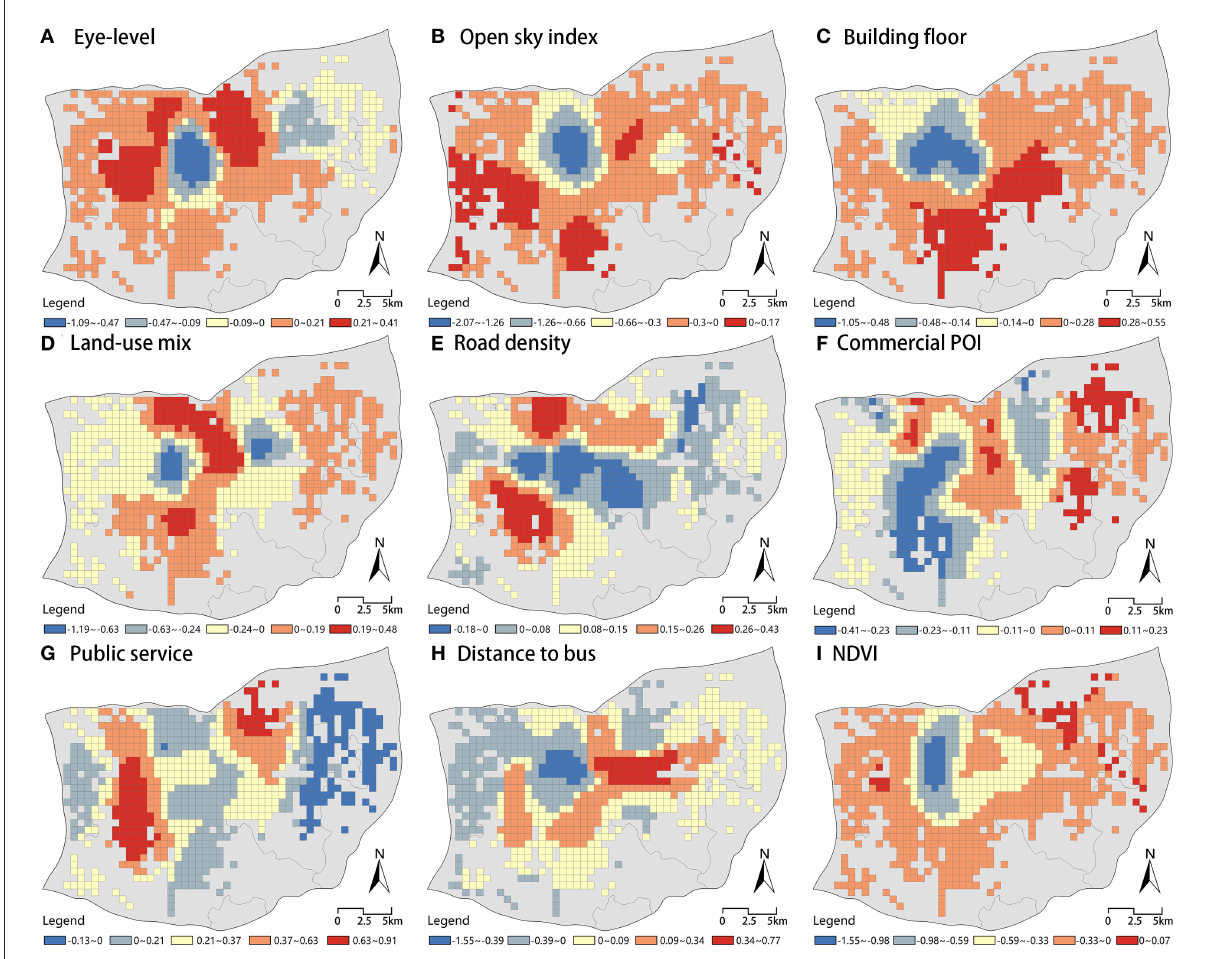
FIGURE5 Spatial pattern of coefficients in different models. (A) Eye-level greenery. (B) Open sky index. (C) Building floor area. (D) Land-use mix. (E) Road density. (F) Commercial POI. (G) Public service POI. (H) Distance to bus stop. (I)